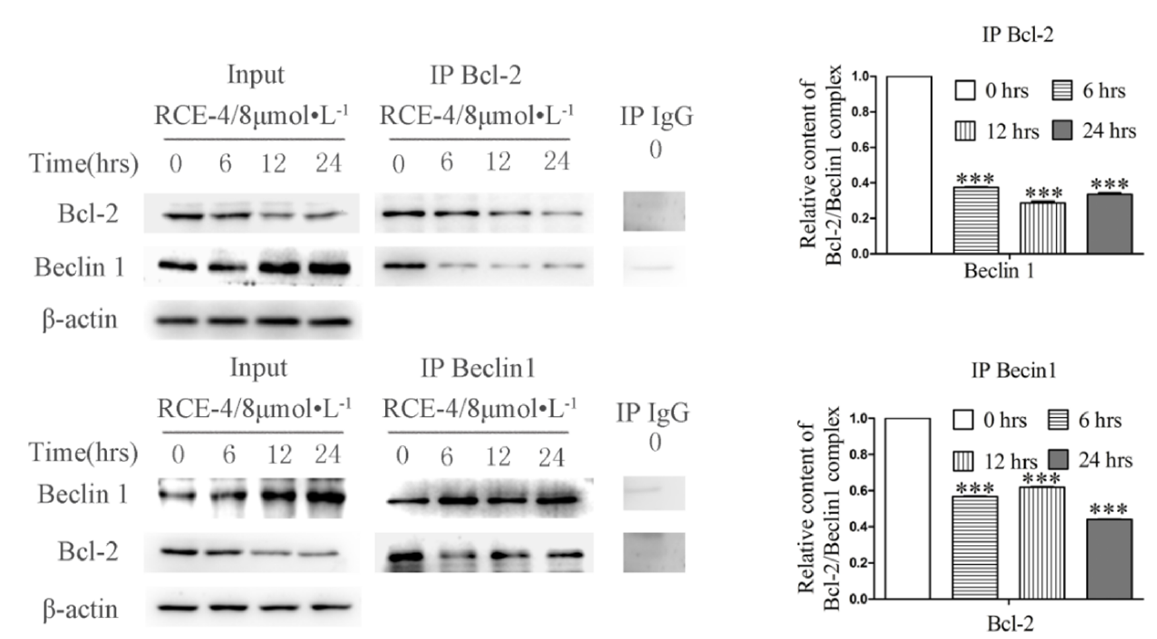
Figure 3. Effect of RCE-4 on the Bcl-2–Beclin 1 complex in Ca Ski cells. Co-IP was used to confirm the effects of RCE-4 on the Bcl-2–Beclin 1 complex in Ca Ski cells. The Ca Ski cells were treated with RCE-4 of 8 µ mol/L for 6, 12 and 24 h. Whole cell lysates were purified using Protein A/G PLUS-Sepharose, and then mixed with Bcl-2, Beclin 1 or control IgG antibodies. The immunoprecipitate was captured on Protein A/G PLUS-Agarose and analyzed using western blotting with antibodies against Bcl-2 and Beclin 1. Relative expression of Beclin 1 and Bcl-2 expressed as a percentage of the untreated group, and relative content of the Bcl-2–Beclin 1 complex in Ca Ski cells. Data are presented as the mean ± standard deviation of three independent experiments. *** p < 0.001 vs. Control.